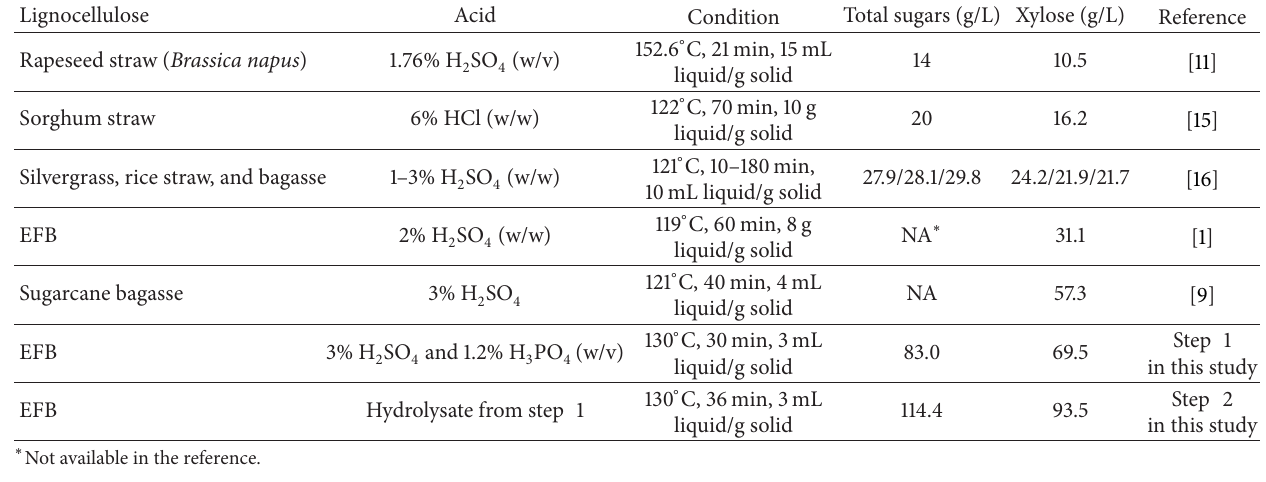
Table 3: Comparison of total sugar and xylose concentrations in acid hydrolysate with literature results.